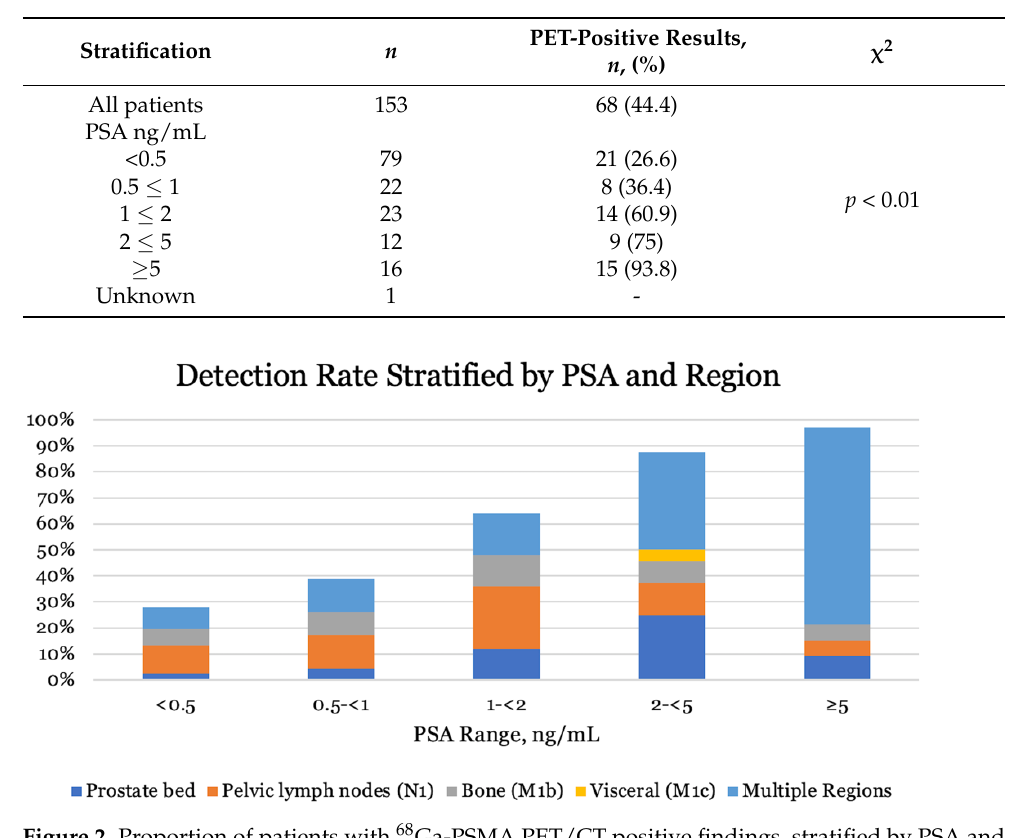
Table 4. 68 Ga-PSMA PET/CT detection rate dependent of PSA at recurrent disease, RP and RT com- bined.